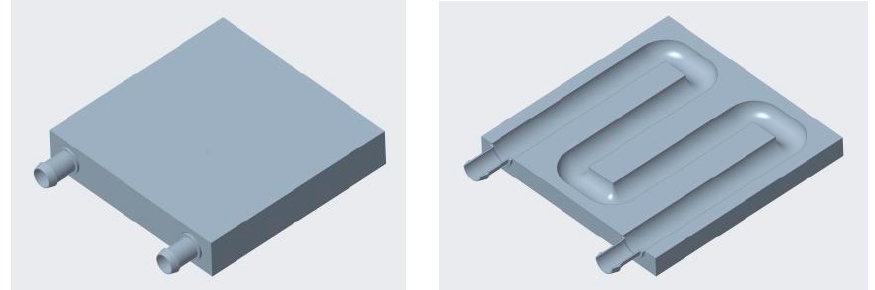
Figure 1. Cooling plate construction.